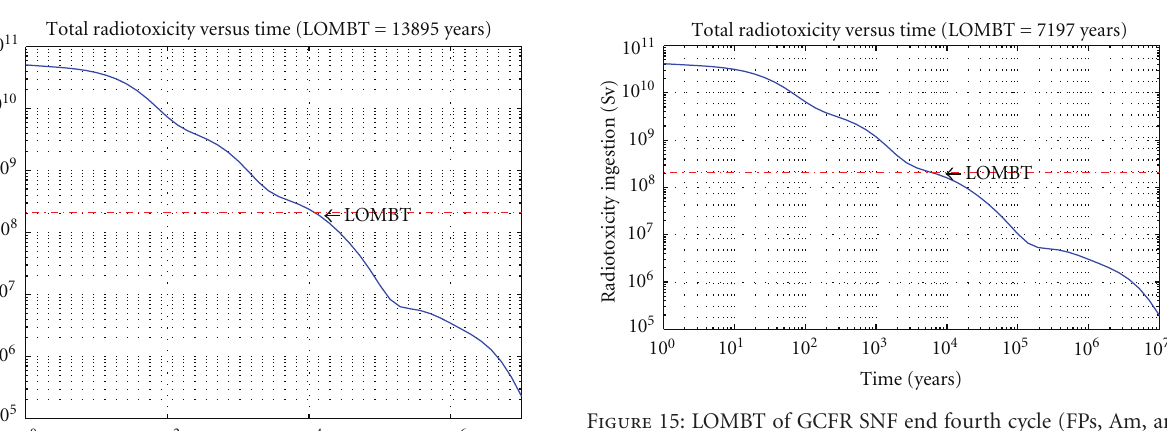
Figure 15: LOMBT of GCFR SNF end fourth cycle (FPs, Am, and Cm).